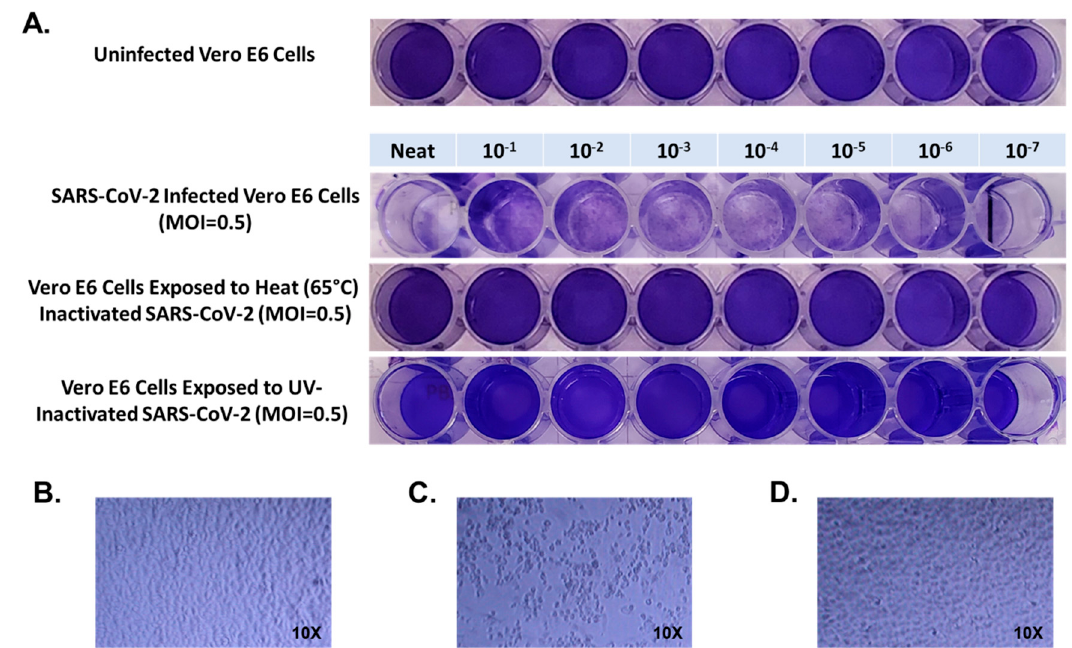
Figure 1. Each experimental condition, and dilution within each condition, were completed in triplicate. Results were consistent within each dilution, therefore a single well per dilution is presented for simplicity. Panel ( A ) presents crystal violet stained uninfected Vero E6 cells, Vero E6 cells infected with severe acute respiratory syndrome coronavirus 2 (SARS-CoV-2) at multiplicity of infection of multiplicity of infection (MOI) = 0.5, Vero E6 cells exposed to SARS-CoV-2 that had been exposed to heat (65 °C) for 10 min, and Vero E6 cells exposed to SARS-CoV-2 that had been treated with UV light (200,000 microjoules over a 5-min). Panel ( B ) presents light microscopy images of uninfected Vero E6 cells, Panel ( C ) presents light microscopy images of Vero E6 cells infected with SARS-CoV-2, and Panel ( D ) presents light microscopy images of Vero E6 cells exposed to heat-inactivated SARS-CoV-2.